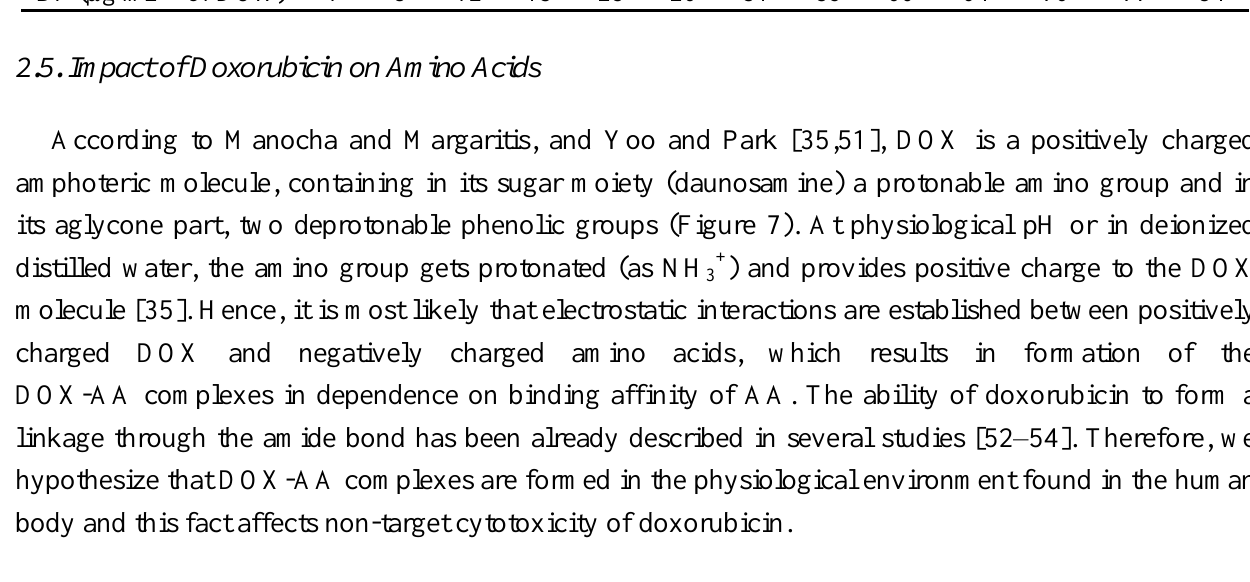
Figure 7. Scheme of the interaction between amino acid and doxorubicin resulting in a complex formation, where * stands for protonable functional group; ** stands for deprotonable